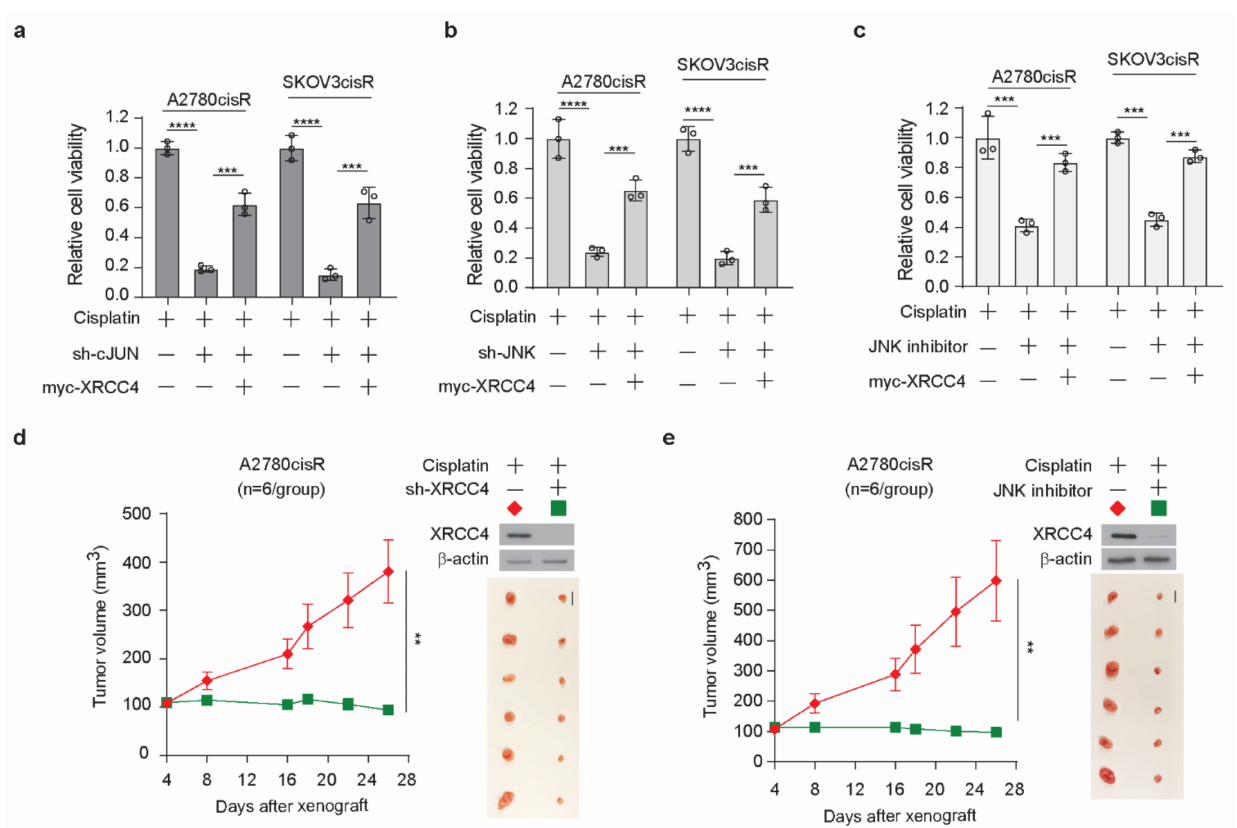
Figure 7. Target inhibition of JNK-cJUN-XRCC4 pathway sensitize cisplatin-resistant ovarian cancer to cisplatin treatment in vitro and in vivo ( a , b ) Cell viability of cisplatin-treated A2780cisR and SKOV3cisR cells with endogenous cJUN ( a ) or JNK ( b ) removed and XRCC4 overexpressed. ( c ) Cell viability of cisplatin-treated A2780cisR and SKOV3cisR cells with JNK inhibitor incubation and XRCC4 overexpressed. ( a – c ) Cells were all treated with the sublethal doses of cisplatin (5 µ g/mL A2780cisR and 2 µ g/mL SKOV3cisR) for 48 h. Cell viability was determined by CellTiter-Glo luminescent cell viability assay. ( d , e ) Effect of XRCC4 knockdown or pharmaceutical inhibition of JNK on the cisplatin-treated tumor growth of ovarian cancer cell line A2780cisR xenograft model. Mice were treated with cisplatin (5 mg/kg) by i.p. injection twice a week. JNK inhibitor SP600125 was administered orally at a total daily dose of 15 mg/kg. Tumor volume and dissected tumors are shown. Scale bar represents 1 cm for dissected tumors. Data are representative of 2 ( a ), 2 ( b ), and 2 ( c ) independent biological experiments. Data are shown as means ± SD (For statistical analyses: tumor volume: 2-way ANOVA; other assay: 1-way ANOVA); ** p < 0.01; *** p < 0.001; **** p <